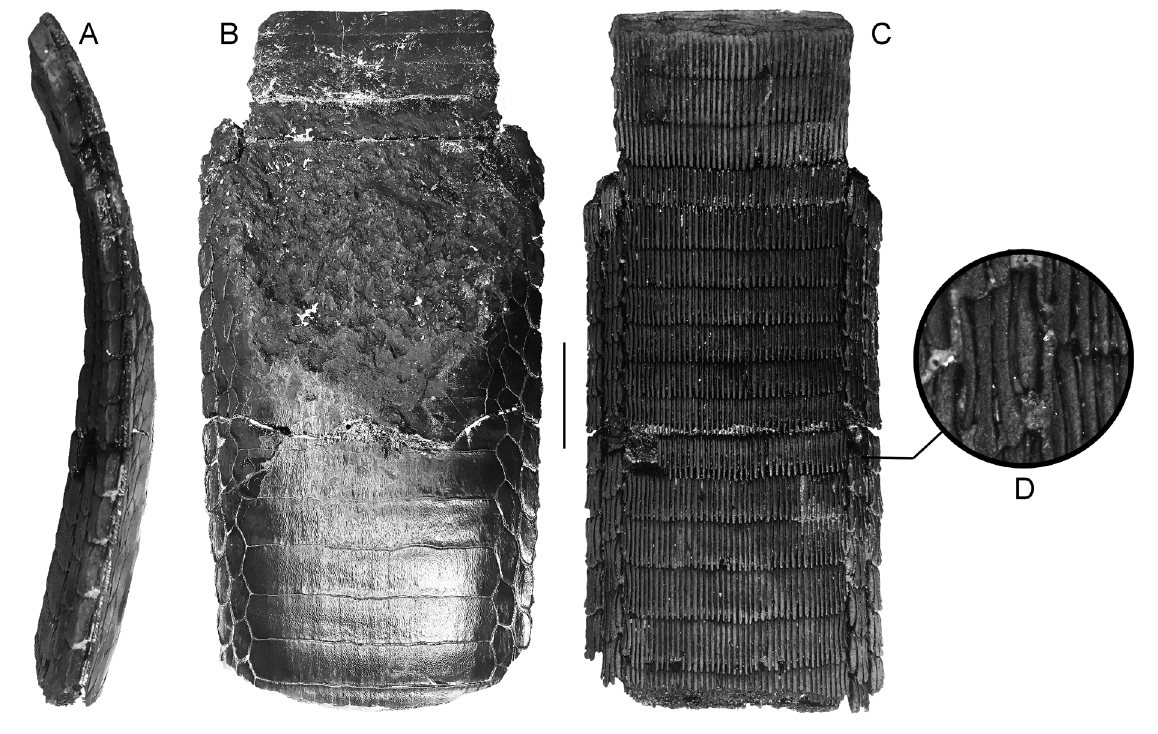
Fig. 45. Aetomylaeus sp., tooth plates. A–D . ALMNH PV2000.1.45, lower tooth plate, “upper” Lisbon Formation. A . Lateral view. B . Oral view. C . Basal view. D . Close–up of root lamilae. Labial at top in A – D. Scale bar = 2